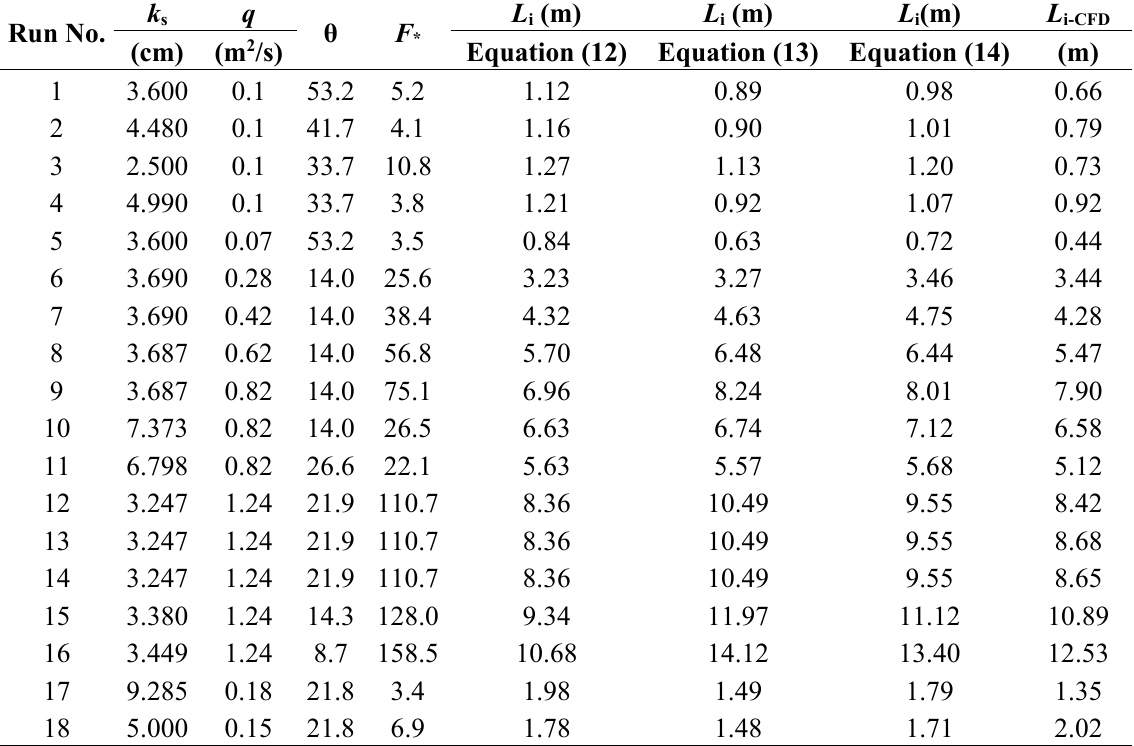
by Equations (12)–(14) and numerical